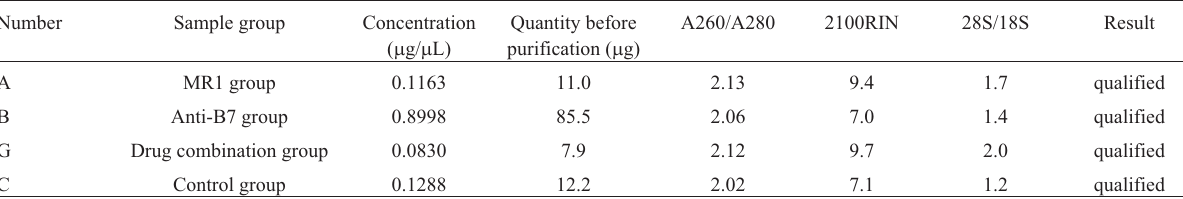
Table 1 - Corneal tissue RNA extraction results.